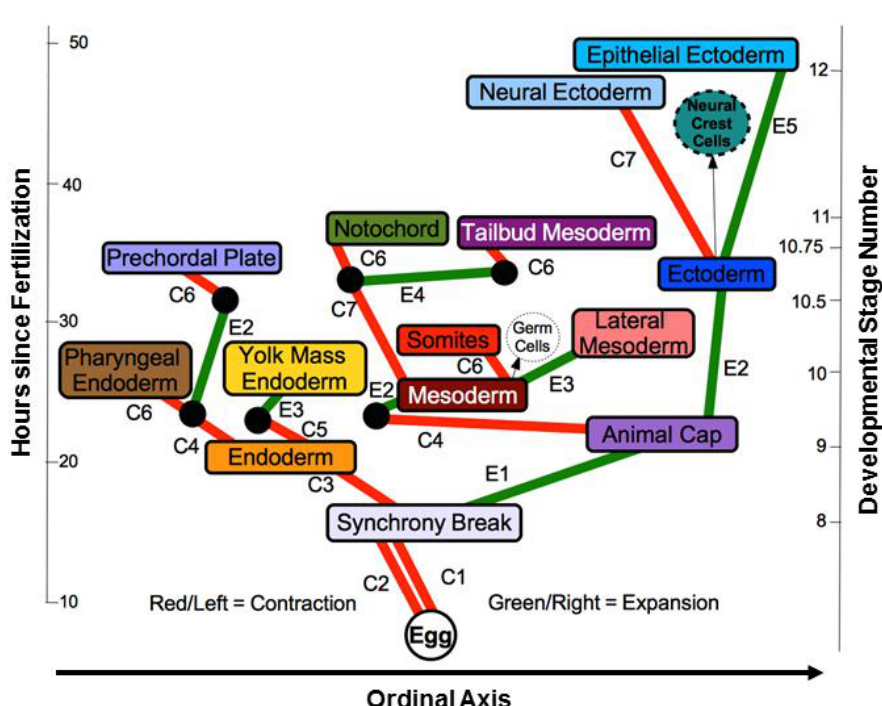
Figure 13. The differentiation tree of the axolotl ( Ambystoma mexicanum ) up to neural plate formation (stages 8–12 raised at 20 ◦ C). All cell types are presumptive. Red branches to the left labelled with the letter C indicates a contraction wave, while green branches to the right labelled with the letter E indicates an expansion wave. The time axis (vertical) is represented in two ways: (1) on the left, are hours since fertilization for embryos raised at 20 ◦ C, (2) on the right are stage numbers based on distinctly recognizable morphological features [49]. Regarded as a vector, the vertical component of each edge represents the duration of each wave. The ordinal axis is horizontal in this figure. Note each numbered wave may pass through one tissue and continue into an adjacent tissue and so, for example, E3 begins in endodermal tissue and then continues into mesodermal tissue. From [10] with permission of World Scientific Publishing. The differentiation codes based on the named tissues (boxes) and unnamed intermediate tissues (black dots) with unique differentiation codes are determined from this tree and shown in Table S6.